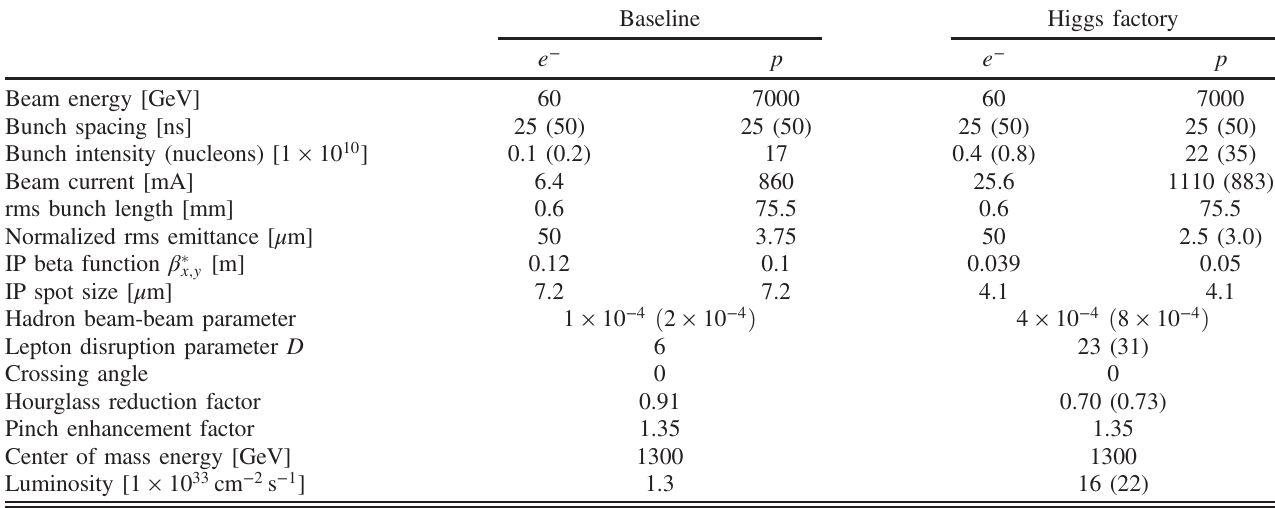
TABLE I. Fundamental beam parameters of the baseline and Higgs factory